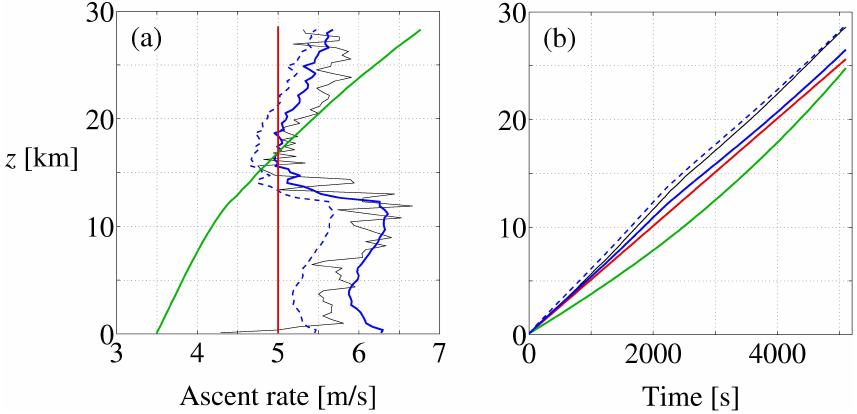
Fig. 7. Comparison of the predictions by different models with data measured during the balloon ascent in the case of LUAMI flight L005 launched on 6 November 2008 at 22:45UTC. Measured data (—); predictions by the present model based either on the shifted reference drag curve (—) or on the reference drag curve itself (–––); predictions by the model by Wang et al. (2009) (—); predictions by the model by Engel (2009) (—). (a) Vertical profile of the balloon ascent rate. (b) Altitude of the balloon as a function of